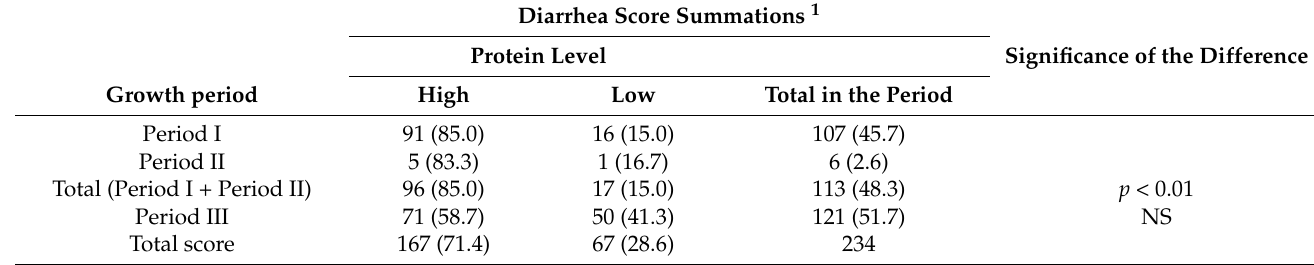
Table 6. Influence of dietary protein level on the diarrhea score summations. The percentages of the scores are shown in parentheses with respect to the total score, referring both to the protein level in the period and to the whole